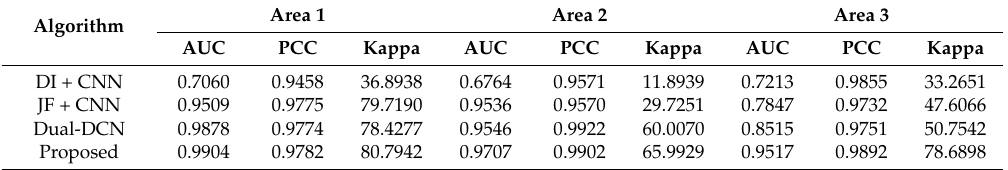
( d ) Figure 9. Detection results for three areas when using the existing and proposed algorithms: ( a ) DI + CNN, ( b ) JF + CNN, ( c ) dual-DCN, and ( d ) the proposed fusion network. To evaluate the effectiveness of the proposed two-stage decision, the proposed algorithm also was compared to each individual network output ( D and O ) and the other decision method between